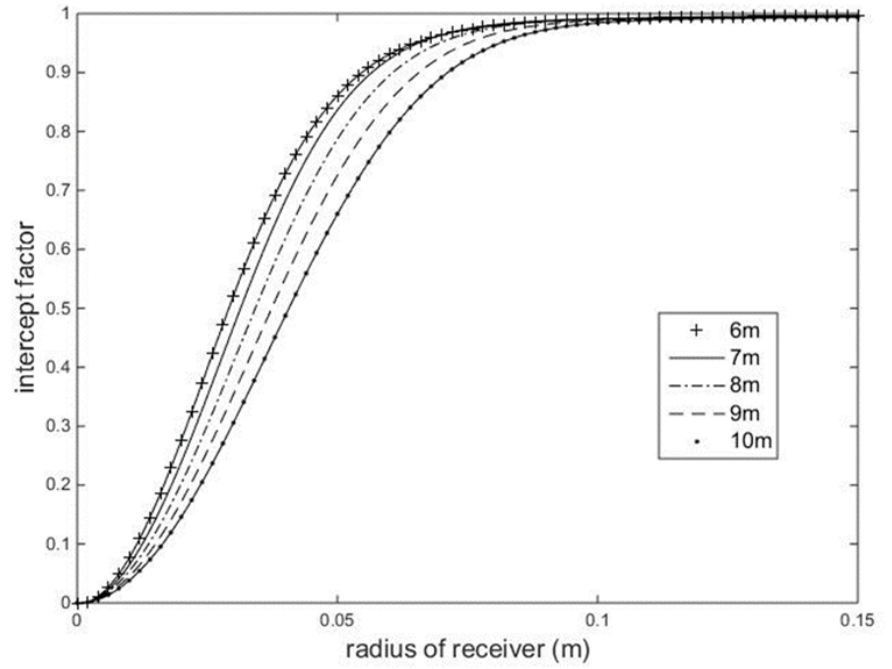
Figure 6. Variation of the system intercept factor with the receiver radius under 6 – 10 m focus length of the system, when the optical error is 2 mrad (f x = f p ). of the system, when the optical error is 2 mrad (f x = f p